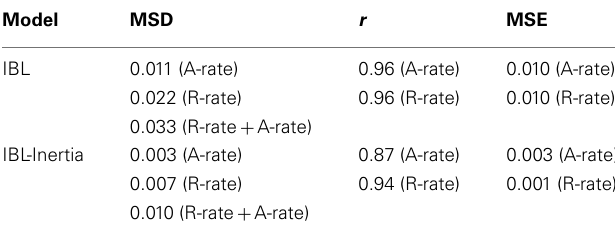
Table 2 |The values of MSD, r , and MSE for IBL and IBL-Inertia models upon their generalization inTPT’s competition